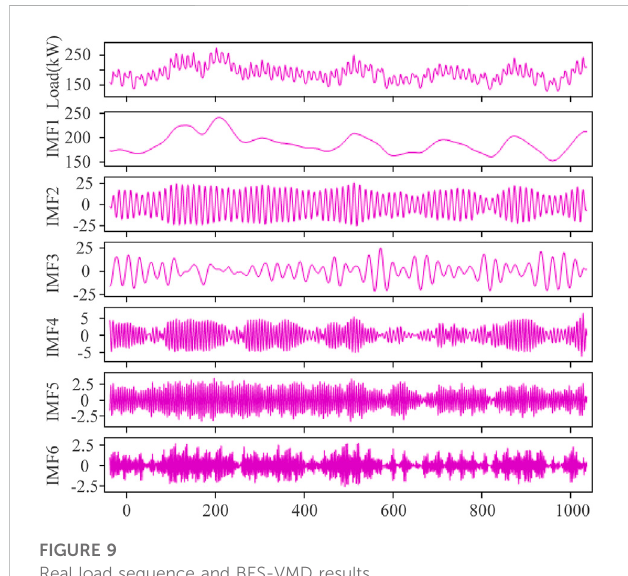
FIGURE 9 Real load sequence and BES-VMD results.